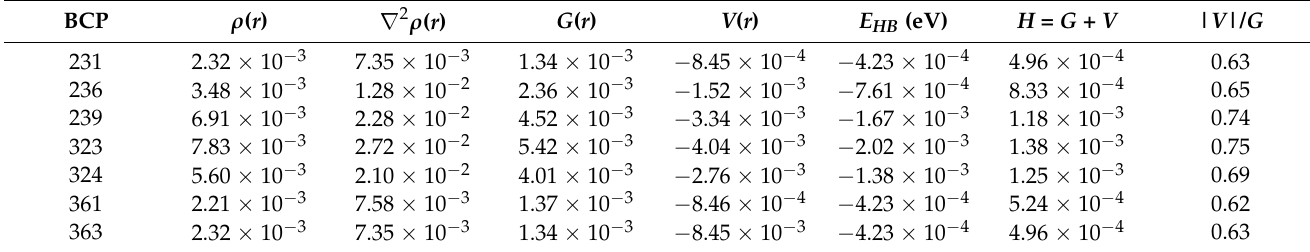
Table 14. The topological characteristics at BCP of interaction contacts in the PANI–amylopectin